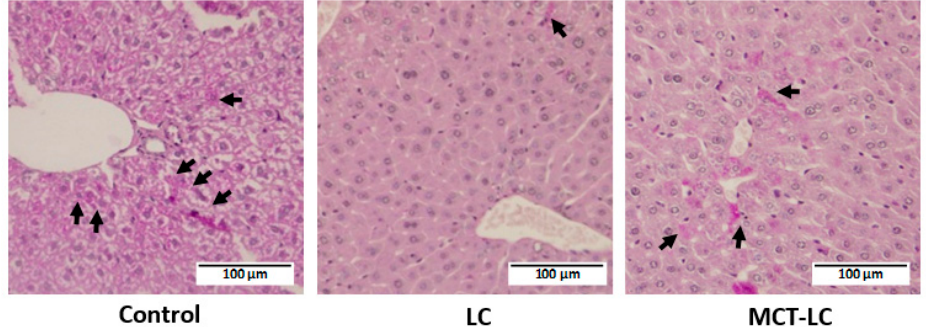
Figure 6. Hepatic glycogen accumulation by PAS staining. Arrows show glycogen accumulation area. Control, control diet; LC, low-carbohydrate diet high in lard; MCT-LC, low-carbohydrate diet high in medium-chain triglyceride.